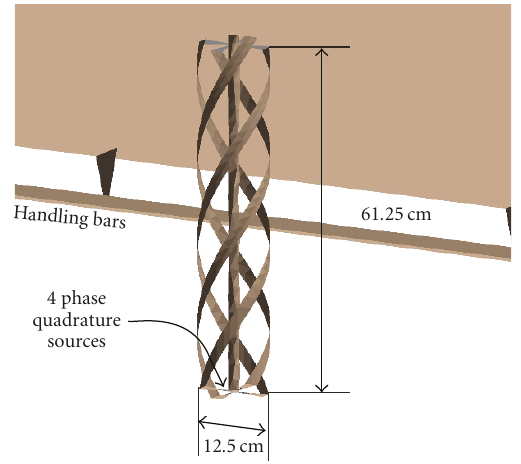
Figure 6: Model of the single turn helical antenna; from FEKO.